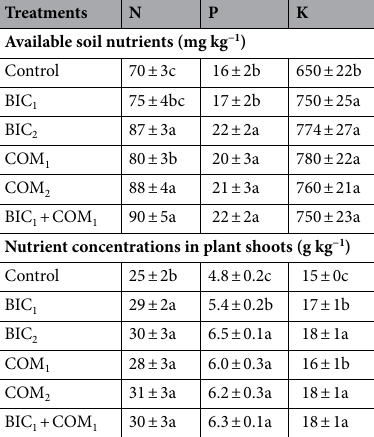
Table 3. Effect of biochar and compost on N, P and K availability and uptake. Means (± SD, n = 5) denoted by the same letter indicate no significant difference according to Tukey’s multiple range tests at p < 0.05.